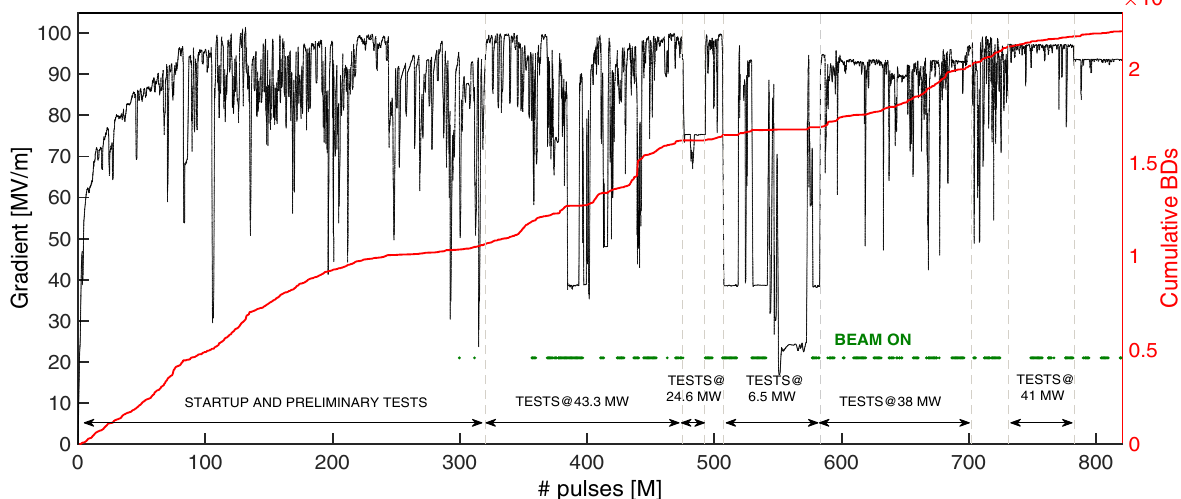
FIG. 2. Gradient and cumulative number of breakdowns during the operation of the cavity under test. The duration of tests at different input power is outlined at the bottom of the figure, and the beam presence is indicated by the green